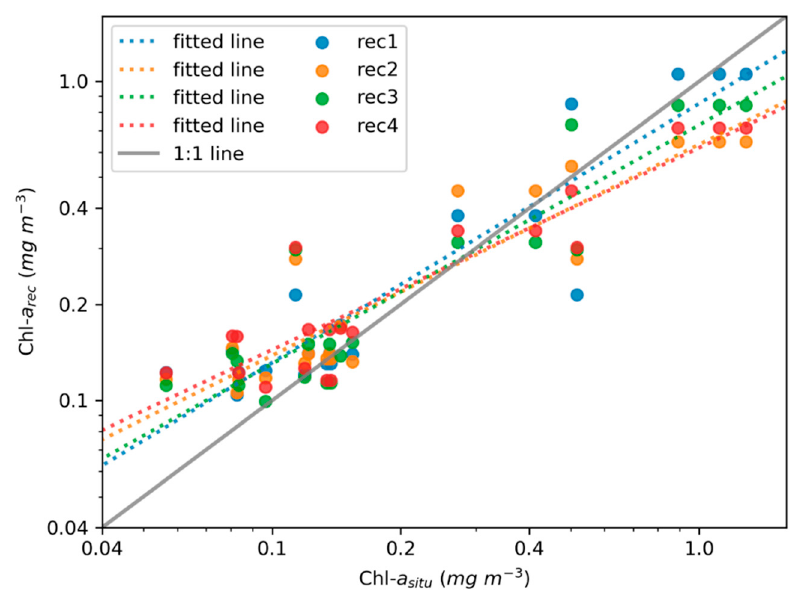
Figure 13. Comparison of the reconstructed Chl- a rec data from the four reconstruction schemes, with in situ Chl- a situ data. The dotted lines represent the fitted lines for the corresponding scatter points using the same colors, for the four schemes. The grey solid line represents the ideal line. Table 4. Relationship between Chl- a rec values and corresponding Chl- a situ values.